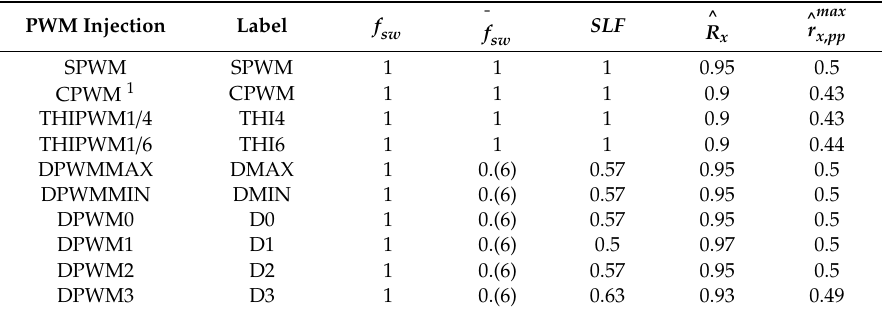
Figure 27. Converter performance comparative Kiviat diagrams at φ = 0 and m = 0.5. Metrics, switching frequency ( a ), average switching frequency ( b ), switching losses function ( SLF ) ( c ), normalized current ripple rms ( d ), and normalized maximum current ripple peak-to-peak ( e ). Table 1. Same switching frequency performance comparison data for ϕ = 0 and m =